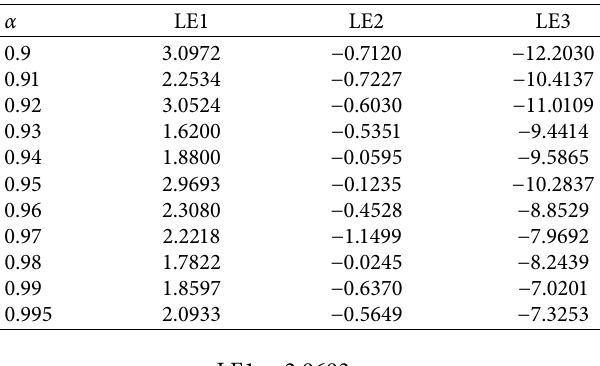
Figure 20: Phase portraits of the fractional system with k � 5 and α � 0 . 95. Table 1: Lyapunov exponents according to order α